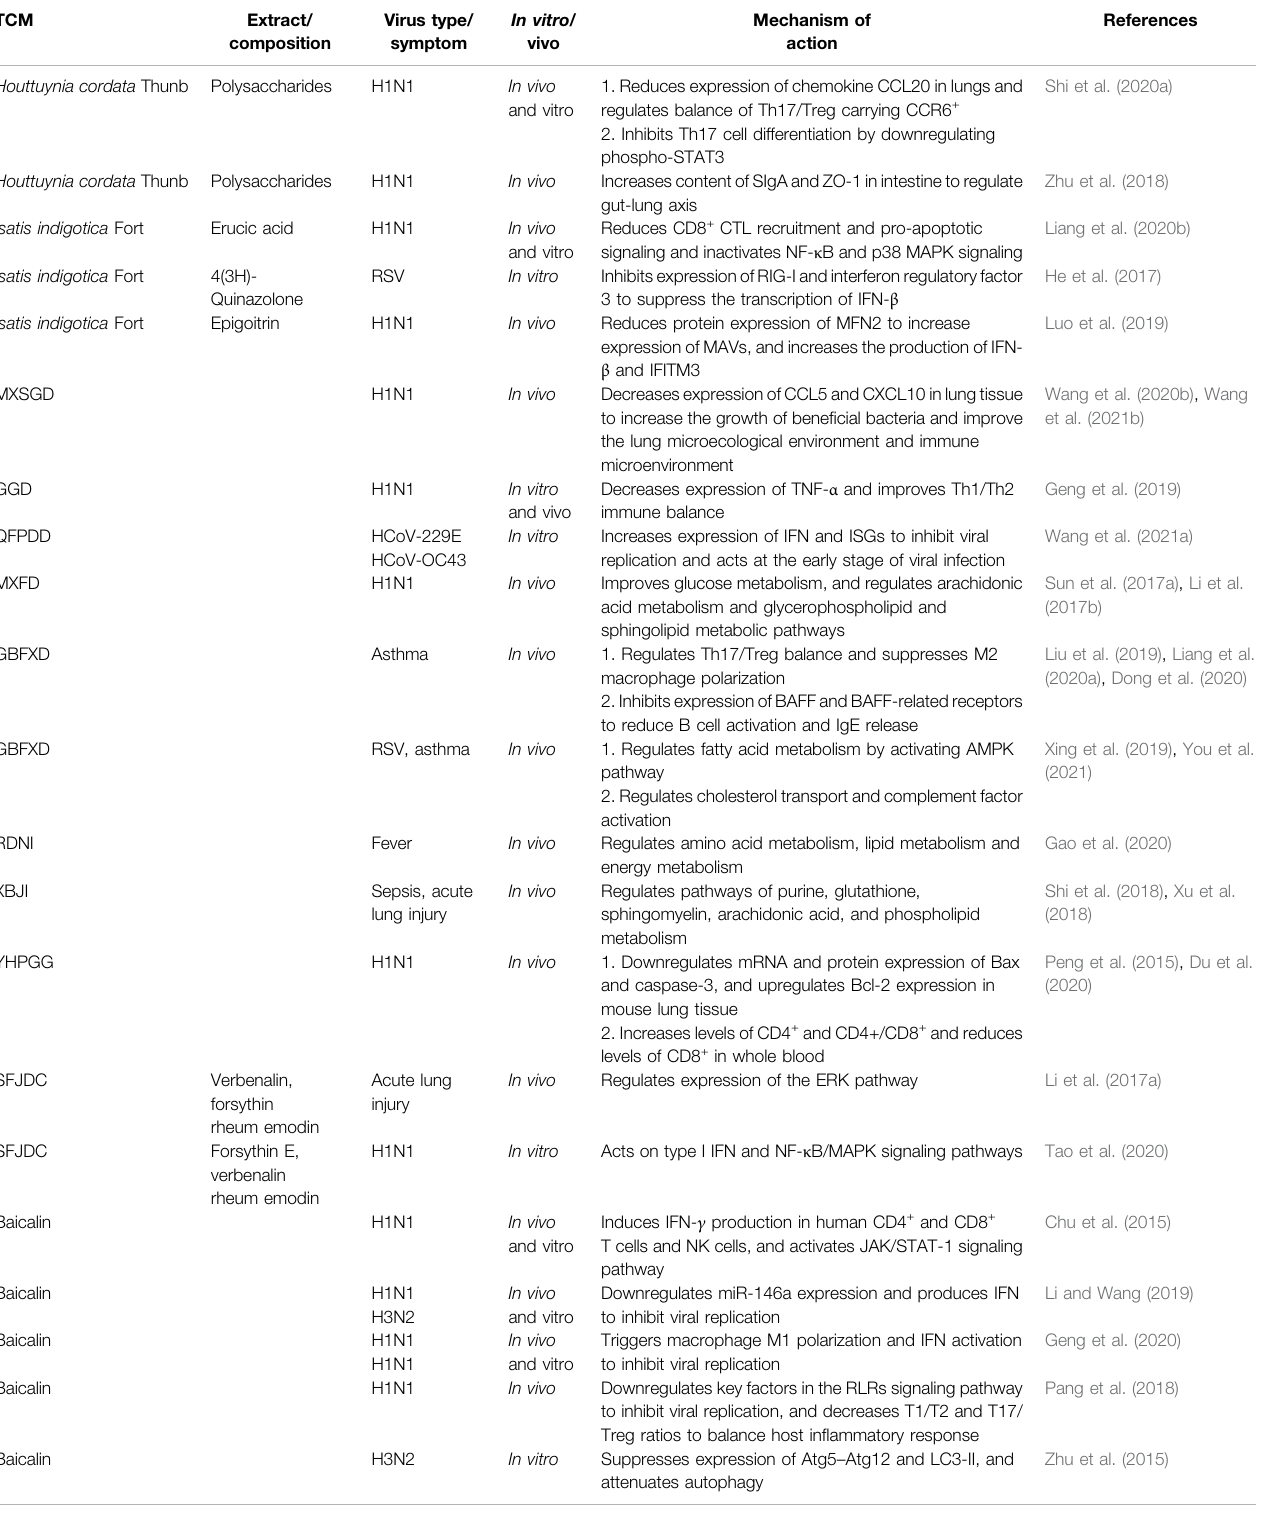
TABLE 3 | Immunomodulatory